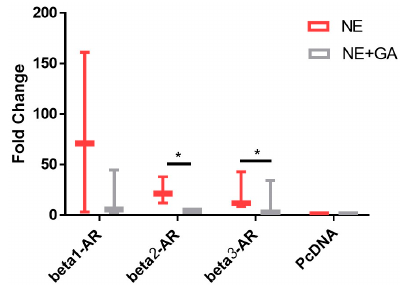
Figure.1. Fold change in the cAMP levels upon activation of adrenergic receptors by 0.1 µM Nor-epinephrine alone (NE) alone and activation of adrenergic receptors by 0.1 µM Nor-epinephrine in the presence of 10 µM (GA) glycyrrhizic acid (NE + GA). GA along with NE results in a statistically significant reduction in the cAMP levels when compared with NE alone in CHO overexpressed with Beta 2-adrenergic receptor ( p value = 0.041) and Beta 3-adrenergic receptor ( p value = 0.021) (N = 3, n = 9). * p < 0.05.